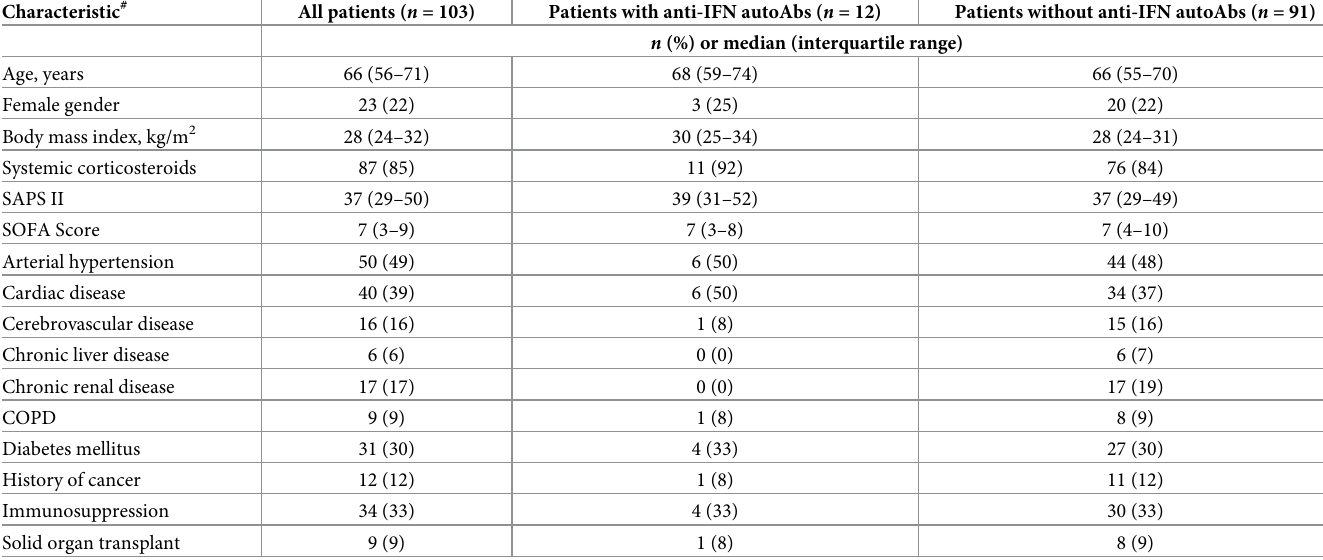
Table 1. Patient baseline